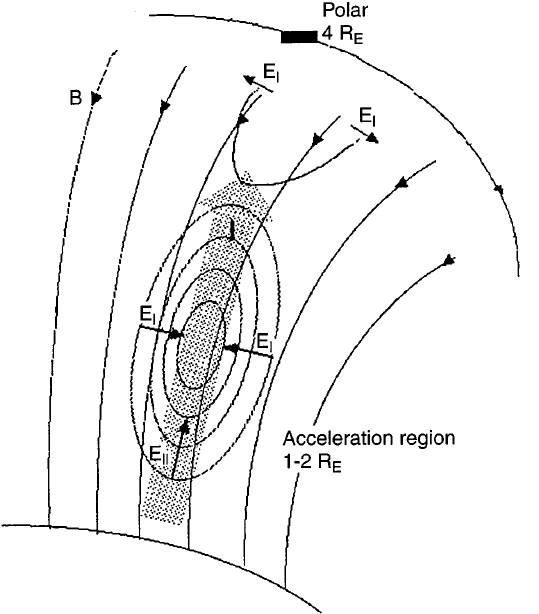
Fig. 11. An‘‘over-closed’’O-shapedpotential.Thedownwardparallel electricfieldontopofthe‘‘O’’isslightlylargerthantheupwardfieldon the bottom, resulting in divergent perpendicular electric field at Polar altitude. This kind of configuration is suggested by some of